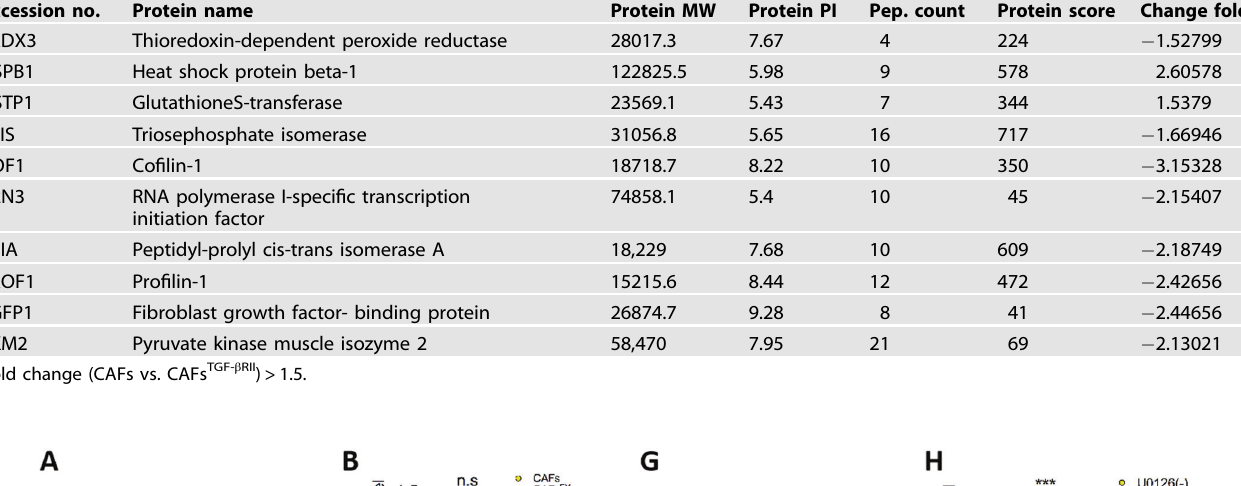
Table 2. Analysis of proteomics related to the glucose metabolism in CAFs with overexpressed TGF- β RII. Accession no.